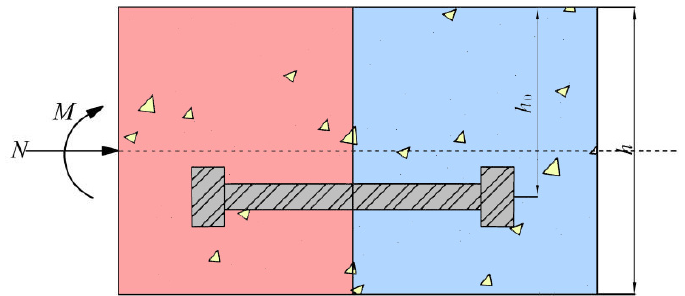
Figure 13. Stress analysis model of the segmental joint (positive bending moment). The segments of a large-diameter deep-buried shield tunnel present small eccentric compression. In this situation, concrete failure in the compression zone of the segmental joint under positive bending moment is generally earlier than the bolts. Therefore, the joint from stress to failure can be assumed at four stages and the secant method to calculate bending stiffness applies. The bolts in the segmental joints are simplified to elastic–ideal plastic materials. The bending stiffness of the joint under different stress states follows: